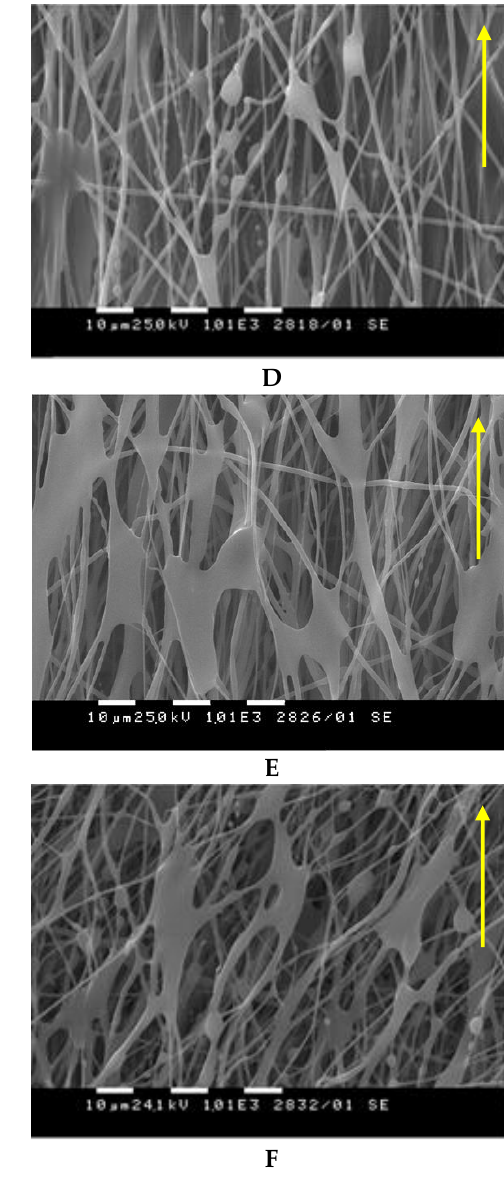
Figure 4. SEM micrographs of the PHB / PCL mats before ( A–C ) and after ( D–F ) thermal treatment onto rotating drum ( A,D ), blade ( B,E ) and grid ( C,F ) collectors. The direction of the collector rotation is indicated by